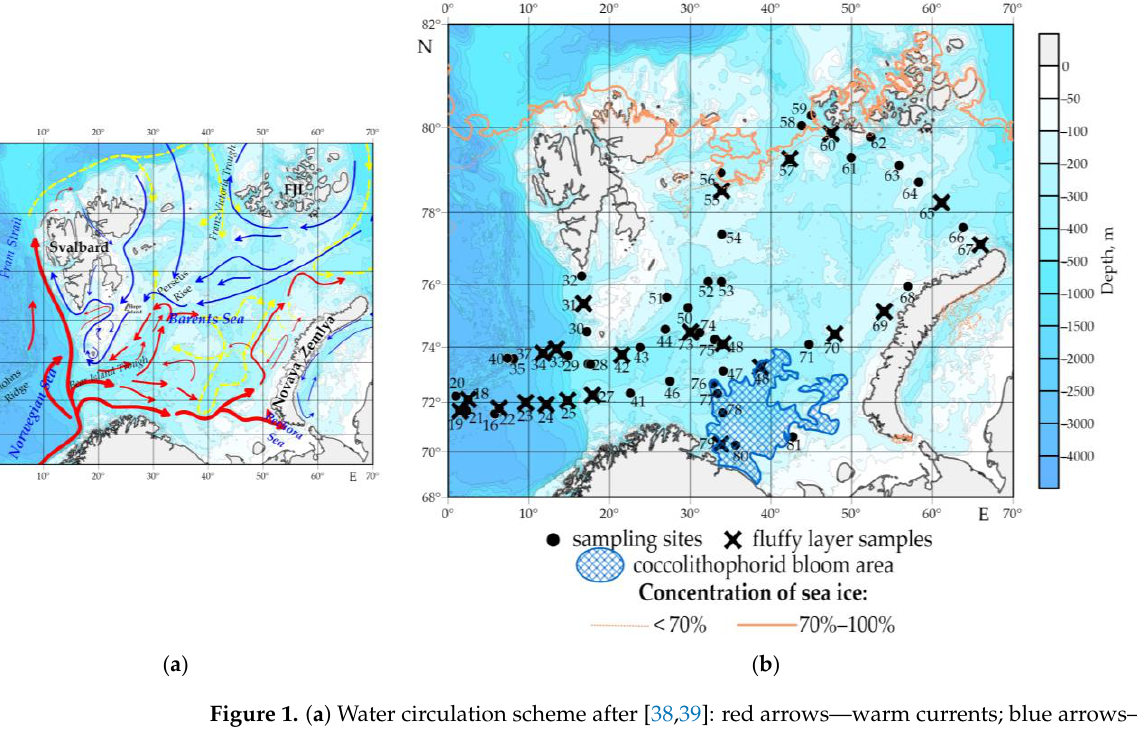
Figure 1. ( a ) Water circulation scheme after [38,39]: red arrows — warm currents; blue arrows — cold currents; dashed yellow arrows — subsurface currents. ( b ) Map of SPM and FLSM sampling stations, July — August 2017. Station numbers are omitted in the first two digits. The area of coccolithophorid blooms (>1.5 106 cells/l) according to satellite data in August 2017 [44]; sea ice conditions from satellite imagery on August 8, 2017 [47]. Bathymetric data — IB-CAO [48].